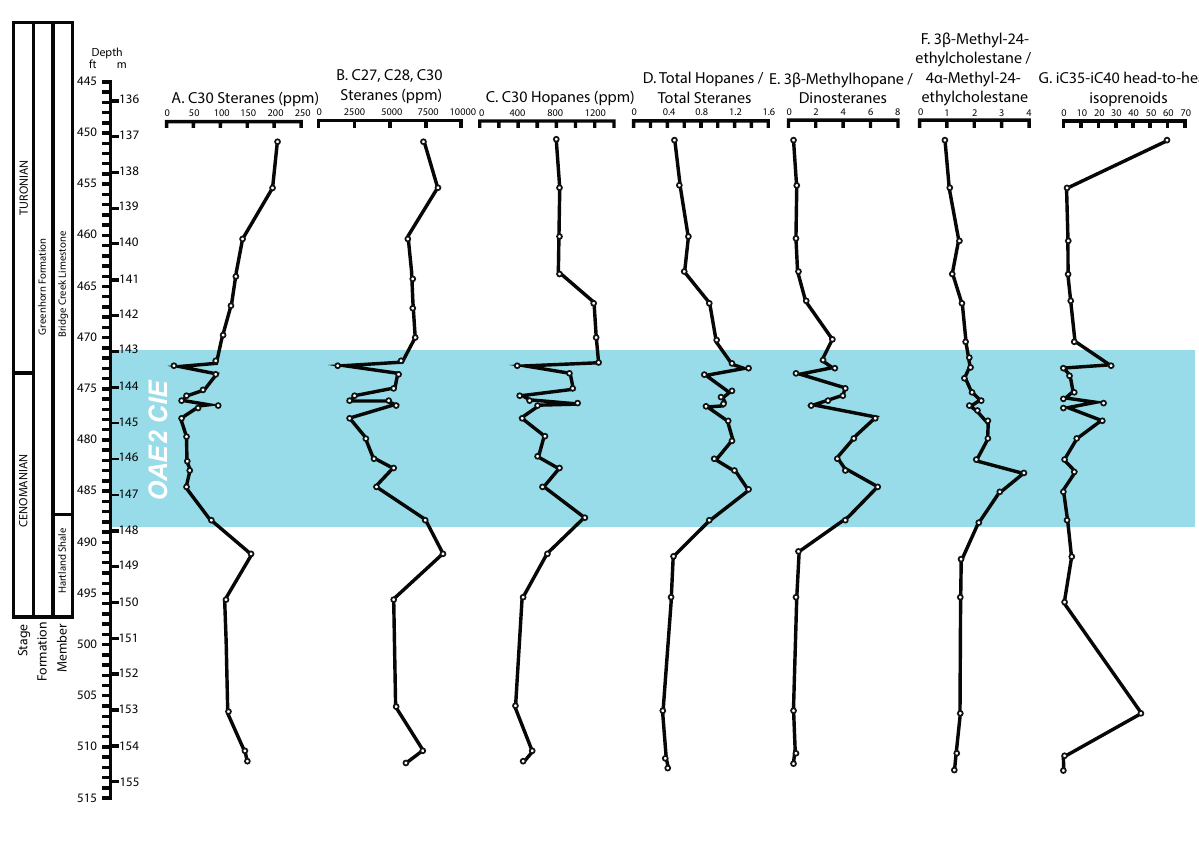
Figure 4. Compound tracks through OAE2 relating to productivity before, during, and after the event. For the main OAE2 section, the concentration of biomarkers derived from algae such as C 27 , C 28 , C 30 steranes (24- n -propylcholestanes), and 4α-methyl-24-ethylcholestane 20R decreases significantly relative to concentrations of those derived from bacteria, which increase moderately with variations. This suggests that the record of productivity variability we interpret is reliable and is not simply a record of poor preservation of the organic fraction. Of note is the interval in all track from ca. ca. 473 feet to ca. 479 feet where organic geochemical measurements return the most erratic results. By applying the most recently published timescales through this interval, it is possible to calculate that the productivity cycles of biomarker decline and recovery can vary from ca. 26 kyr at the shortest to ca. 130 kyr at the longest. These productivity cycles occur within individual lithofacies internal to single